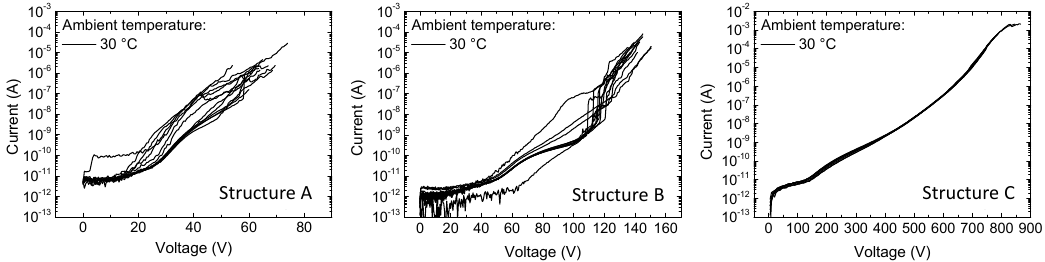
Figure 4. Vertical current-voltage (I–V) characteristics until breakdown for ten devices on structure A ( left ), structure B ( center ) and structure C ( right ).